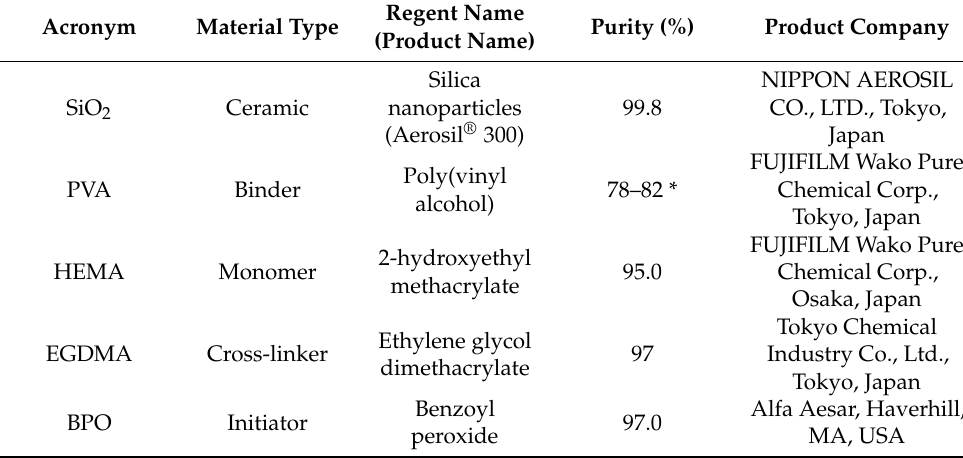
Table 1. Reagents used to prepare the SiO 2 /pHEMA-based